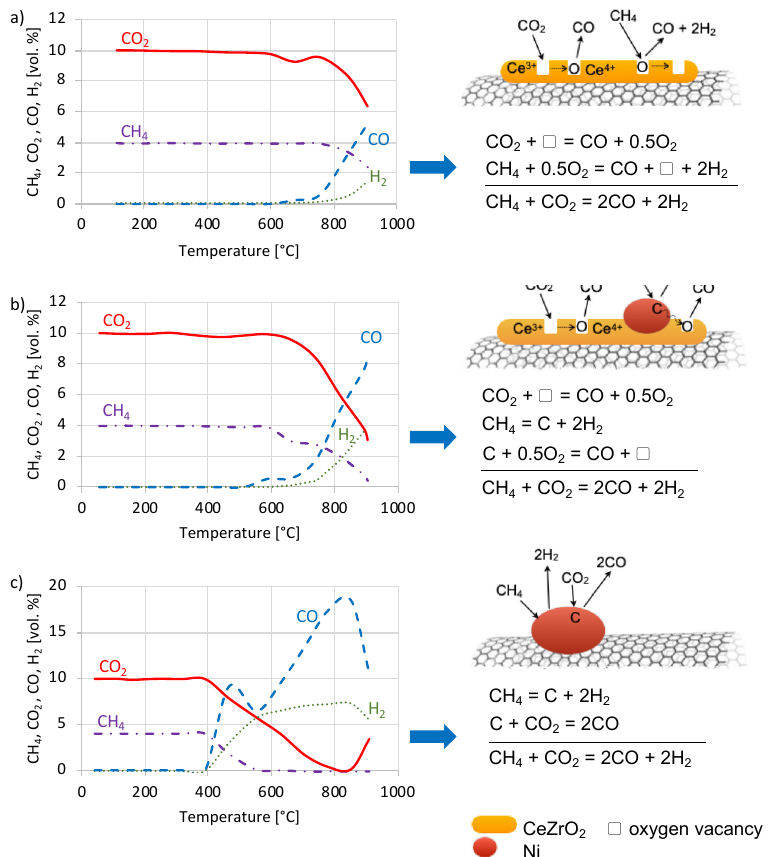
Figure 7. The evolution of CH 4 , CO 2 , H 2 and CO during tests of dry reforming of methane (DRM) carried out in temperature-programmed (TP) conditions over CZ / CNT ( a ), NiCZ / CNT ( b ) and Ni / CNT ( c ) and corresponding mechanisms of DRM reaction.